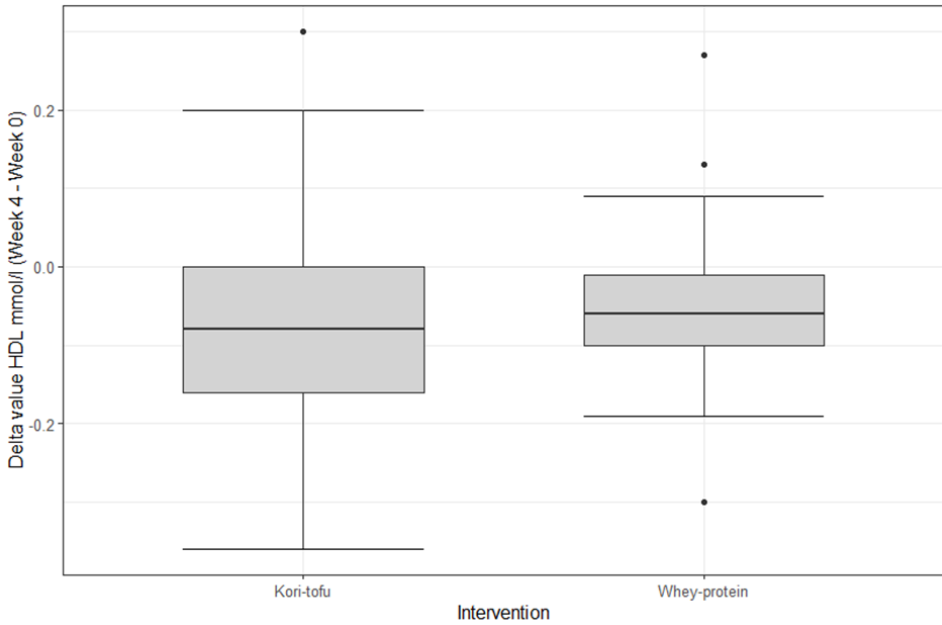
Figure A3. Delta values of HDL cholesterol (mmol/L) per intervention (values week 4–values week 0). Boxplots represent the 25th, 50th (median) and 75th percentile. Antennas represent 1.5 times interquartile range. Dots represent values outside the 1.5 times interquartile range.